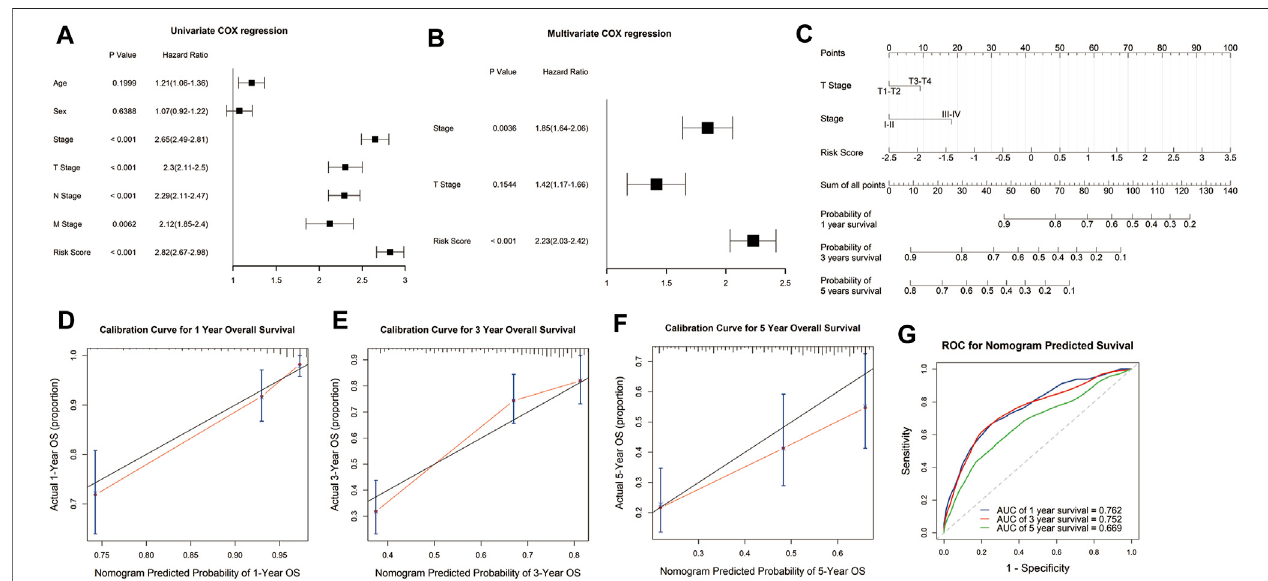
FIGURE 5 | Construction and evaluation of the nomogram. Univariate and multivariate COX regression analysis showed that the risk score was an independent prognostic predictor in theTCGA cohort (A,B) . Anomogramwasconstructed based onthe riskscore, Tstage, and tumor stage (C) .Calibrationplots ofthe nomogram forpredictingtheprobabilityofOSat1-,3-,and5-yearsintheTCGAcohort (D – F) .Time-dependentreceiveroperatingcharacteristic(ROC)curvesforthenomogramto predict 1-, 3-, and 5-year OS in the TCGA dataset (G) .